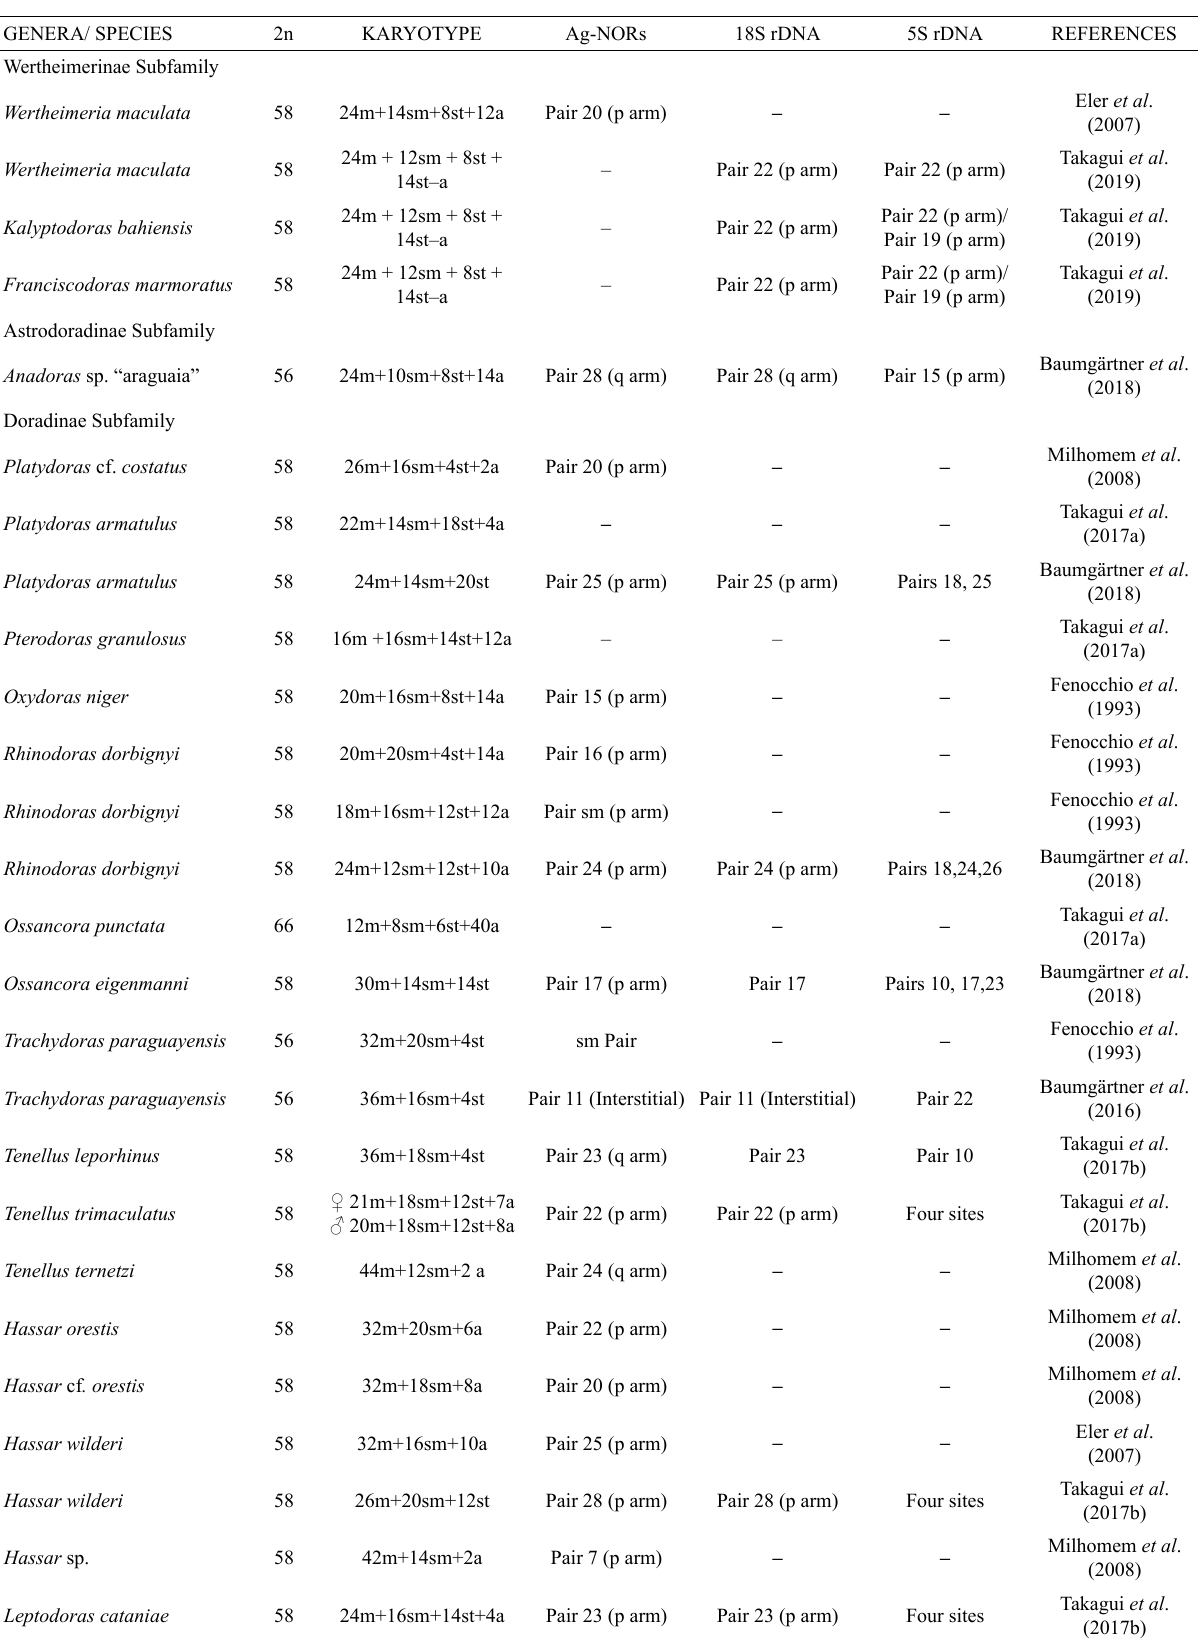
Table 1 – Cytogenetic data available for the Neotropical freshwater fishes of Doradidae family. GENERA/ SPECIES